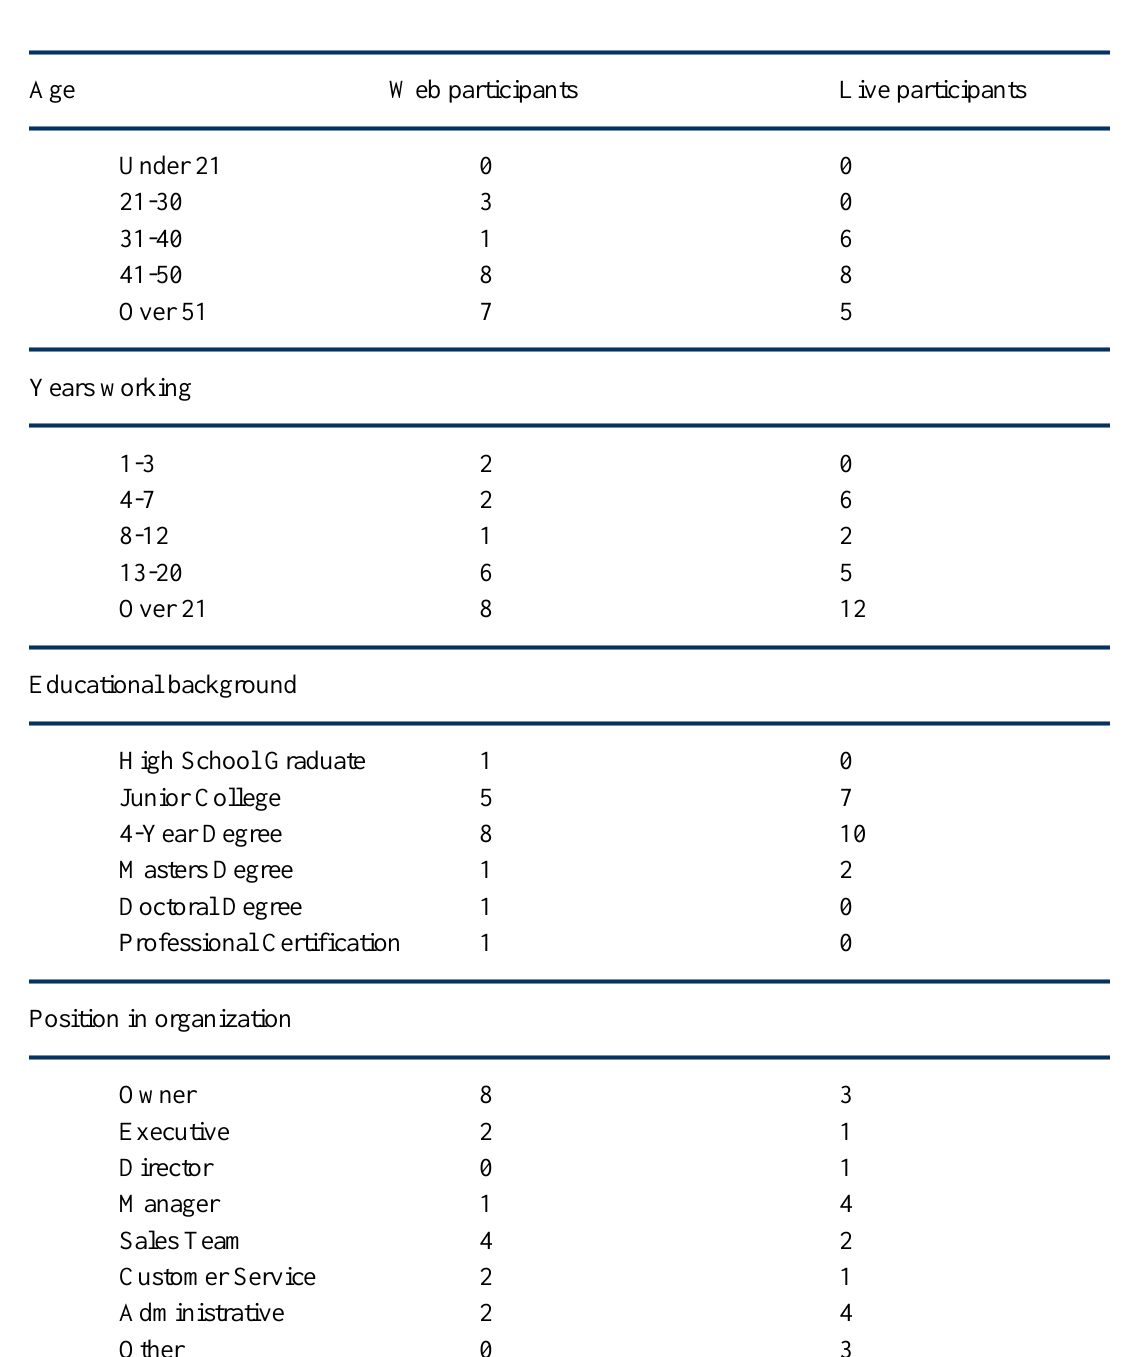
Table 1 Participant Demographics